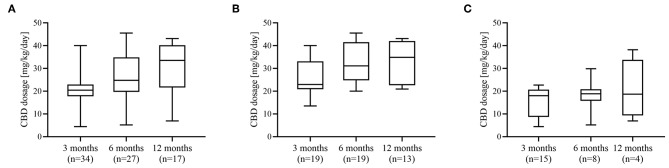
Dosage of cannabidiol. Dosage of CBD (mg/kg/day) administered at 3, 6, and 12 months of treatment in (A) whole cohort, (B) pediatric cohort, and (C) adult cohort.